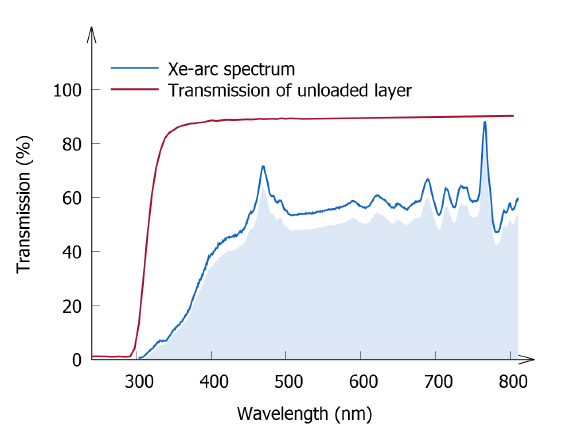
Figure 7. Diffuse transmission spectrum of an unloaded (i.e., without-phosphor) polymer layer. The spectrum of the 1000 lux Xe-arc industrial standard is also depicted. The shaded area indicates the fraction of light that can be used for excitation of the phosphor, taking into account losses due to the glass substrate and